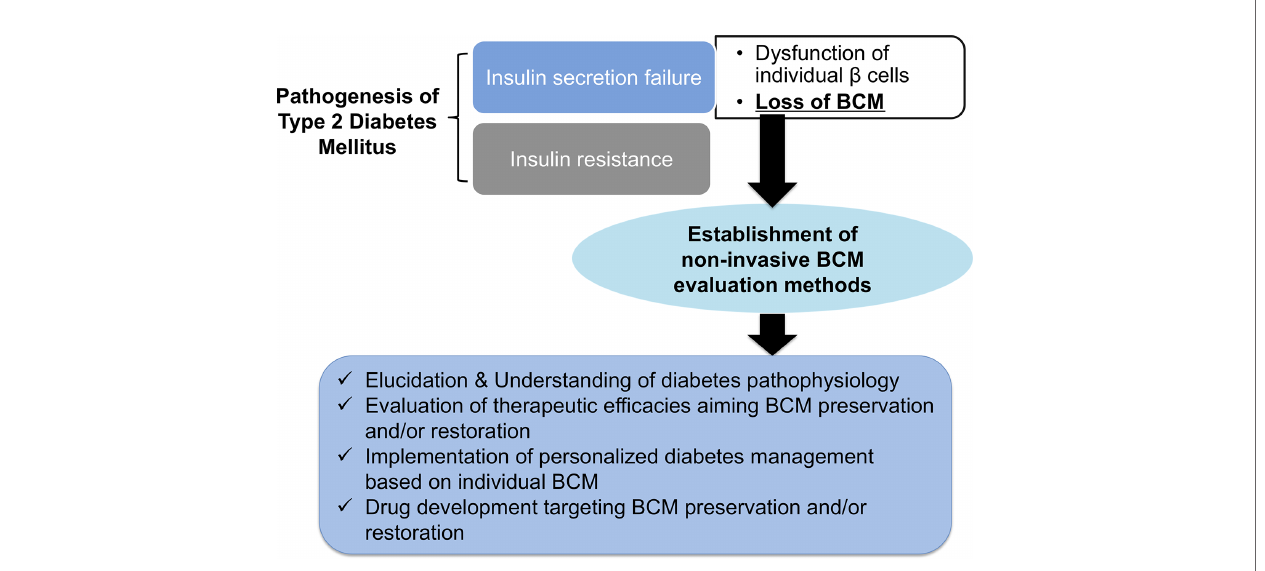
FIGURE 1 | The expected bene fi ts of non-invasive b -cell mass (BCM) evaluation. Loss of BCM has a central role in the onset and progression of type 2 diabetes mellitus. The establishment of non-invasive BCM evaluation methods will open the door to elucidating and understanding the pathophysiology of diabetes, the evaluation of therapeutic ef fi cacies aimed at preserving and restoring BCM, the implementation of personalized diabetes management based on individual BCM, and drug development targeting BCM preservation and